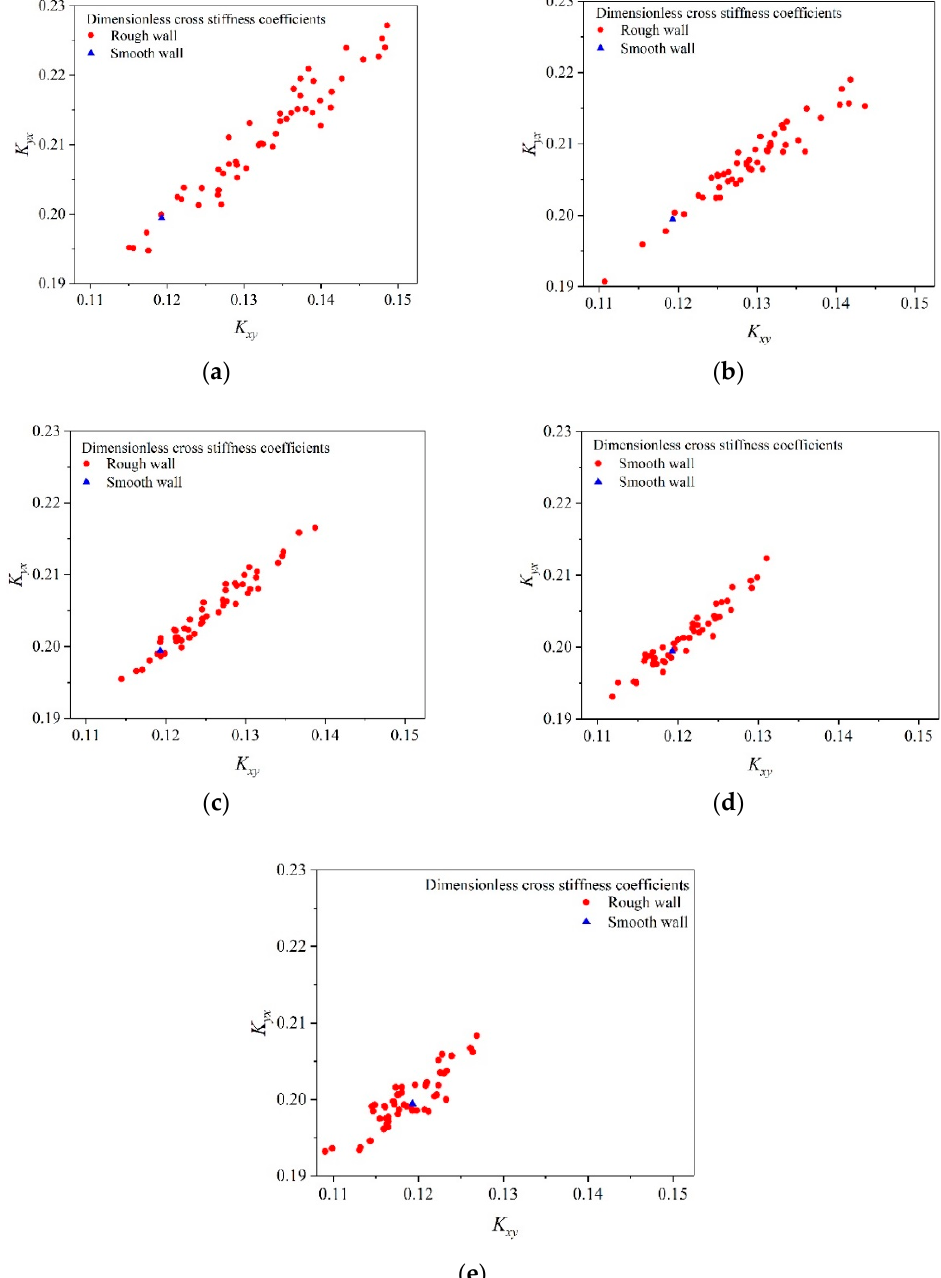
Figure 10. Cross stiffness coefficients distribution with wear in axial regions. ( a ) axial region 1. ( b ) axial region 2. ( c ) axial region 3. ( d ) axial region 4. ( e ) axial region 5.